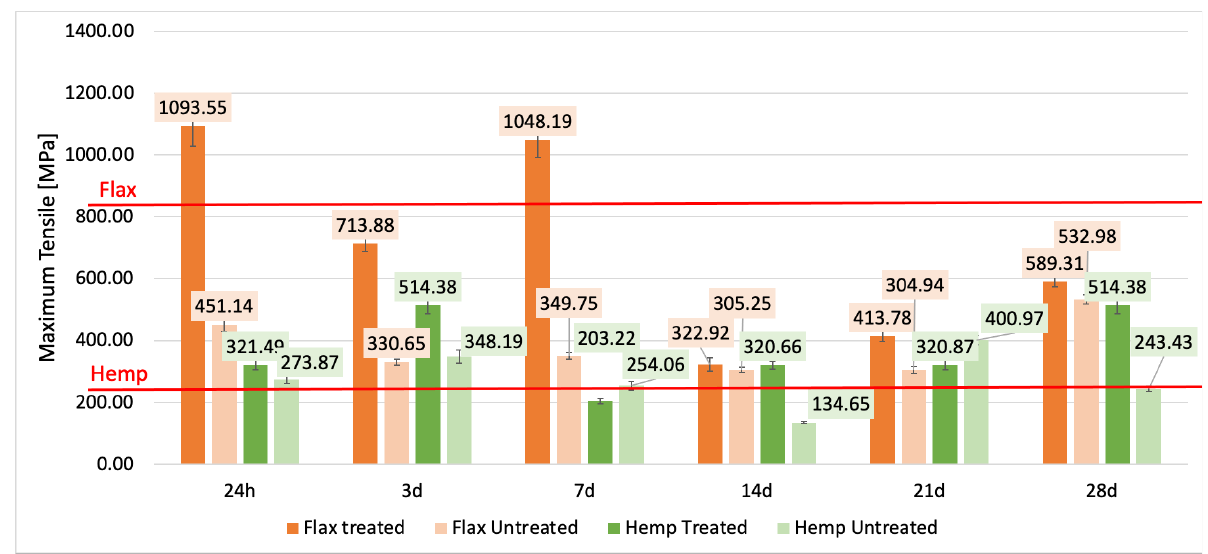
Figure 13. Effects of the degradation at an alkaline solution on the tensile strength.